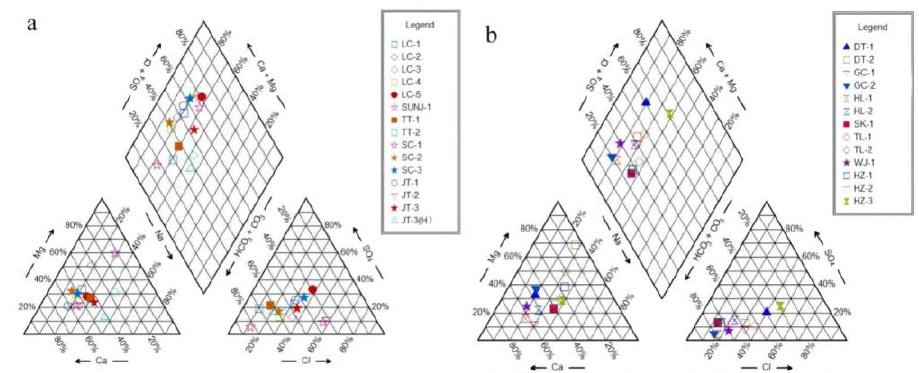
Figure 3. Piper diagram of groundwater in the Mihe alluvial–diluvial fan. ( a ) The water sample of the southern sampling point of the study area, ( b ) is the water sample of the northern sampling point.)